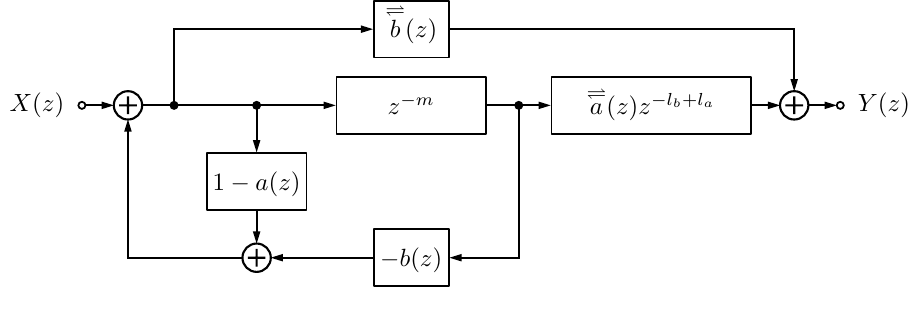
Figure 5. Proposed frequency-dependent allpass for an IIR gain g ( z ) = b ( z )